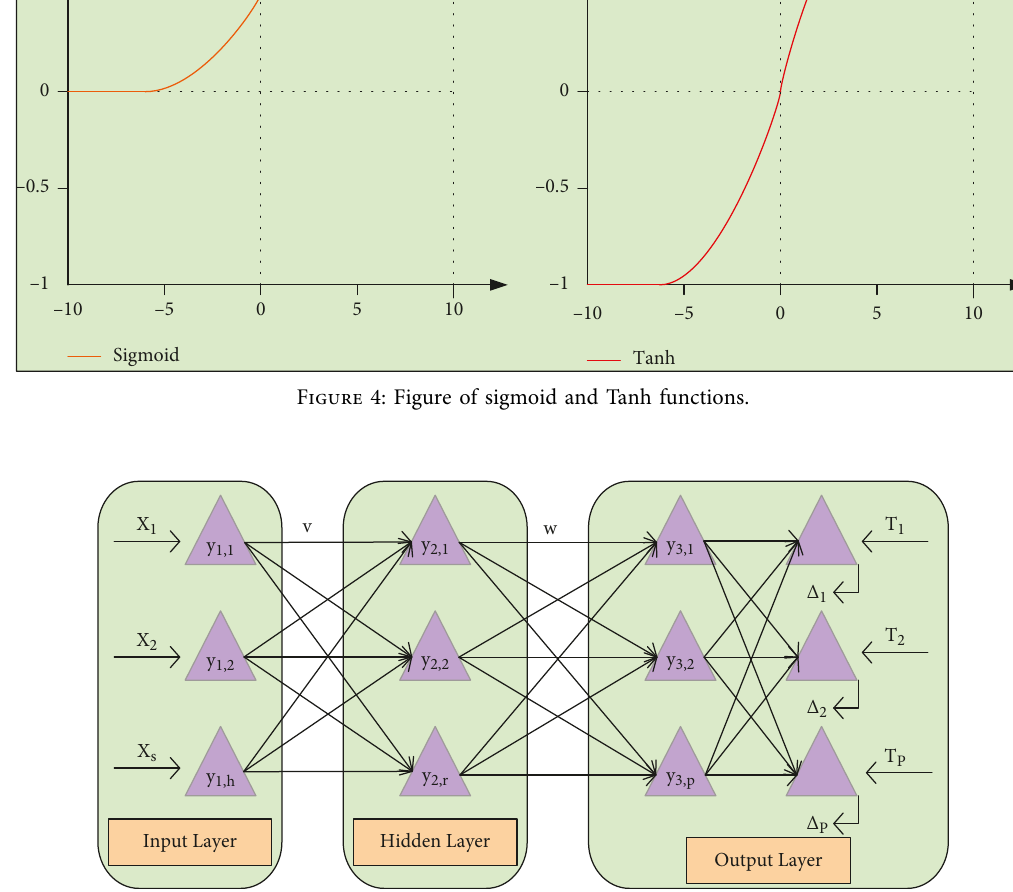
Figure 5: Schematic figure of neural network